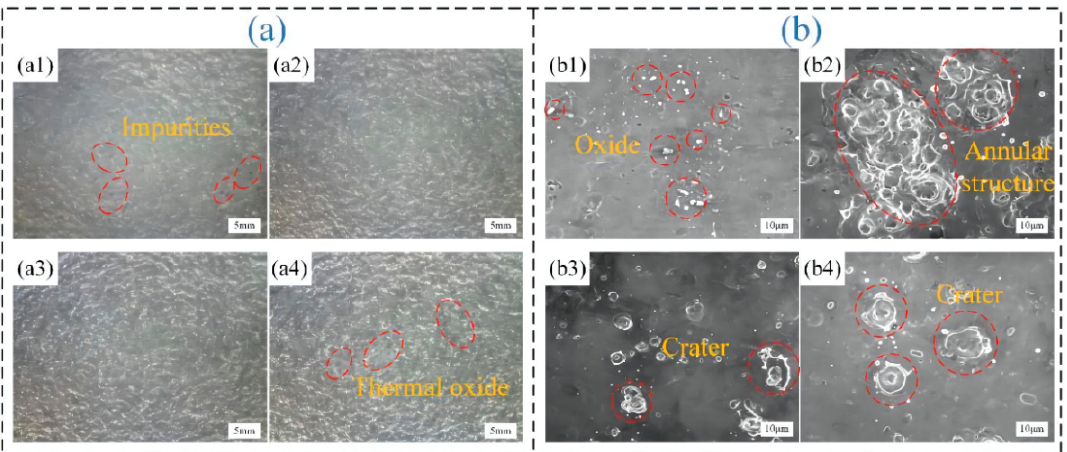
Figure 3. Surface morphology of an aluminum alloy cleaned by a laser with different loading energy densities. ( a ) Macromorphology: ( a1 ): not cleaned; ( a2 ): 8.5 J/cm 2 ; ( a3 ): 10.5 J/cm 2 ; ( a4 ): 12.5 J/cm 2 . ( b ) Micromorphology: ( b1 ): not cleaned; ( b2 ): 8.5 J/cm 2 ; ( b3 ): 10.5 J/cm 2 ; ( b4 ): 12.5 J/cm 2 .